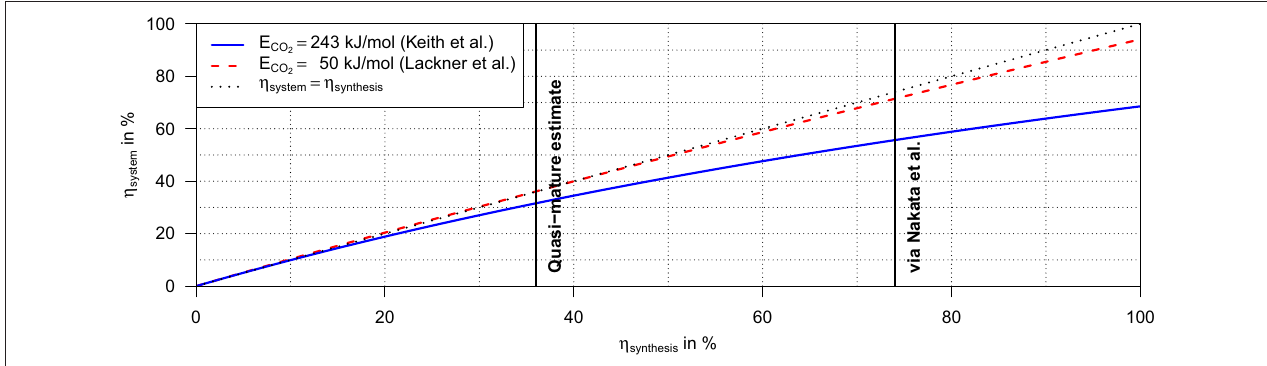
FIGURE 2 | System efficiency of the hexose synthesis dependent on the efficiency of the synthesis 6CO 2 (g) + 6H 2 O(l) → (CH 2 O) 6 (s) + 6O 2 (g) and the energy demand of direct air capture of 1 mole of CO 2